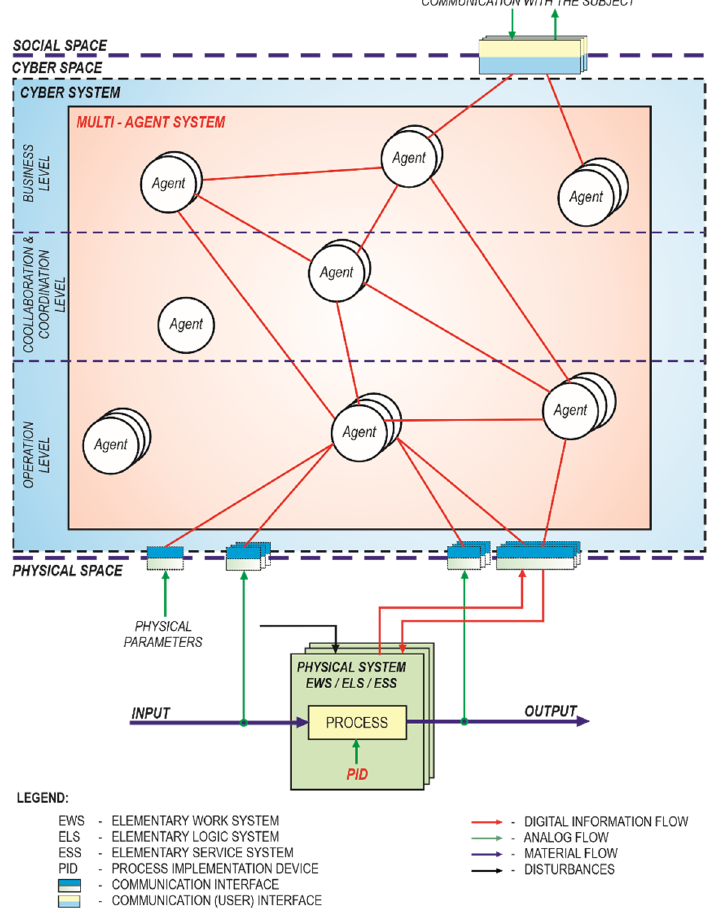
Figure 15. Model of the C-CPPS (Adapted from [85]).